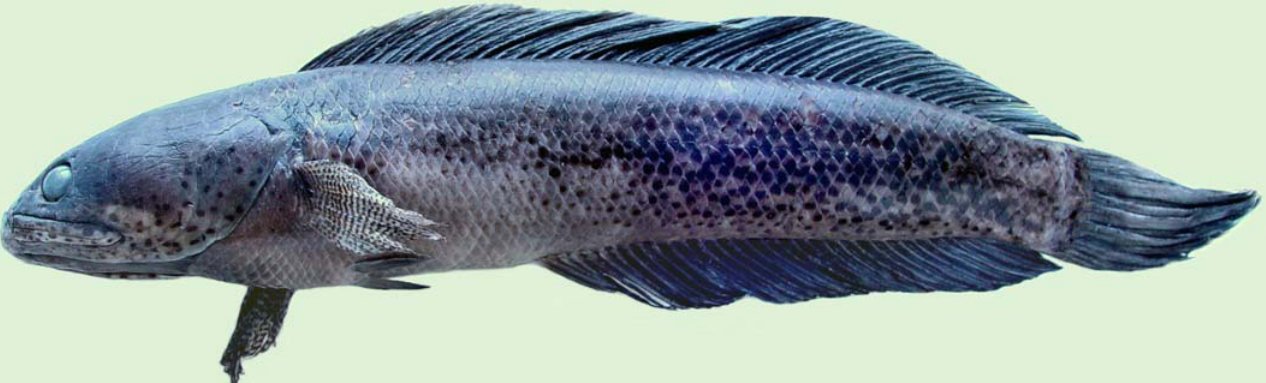
Image 4. Side view of Channa barca (MUMF-Per/0044, 295.0mm